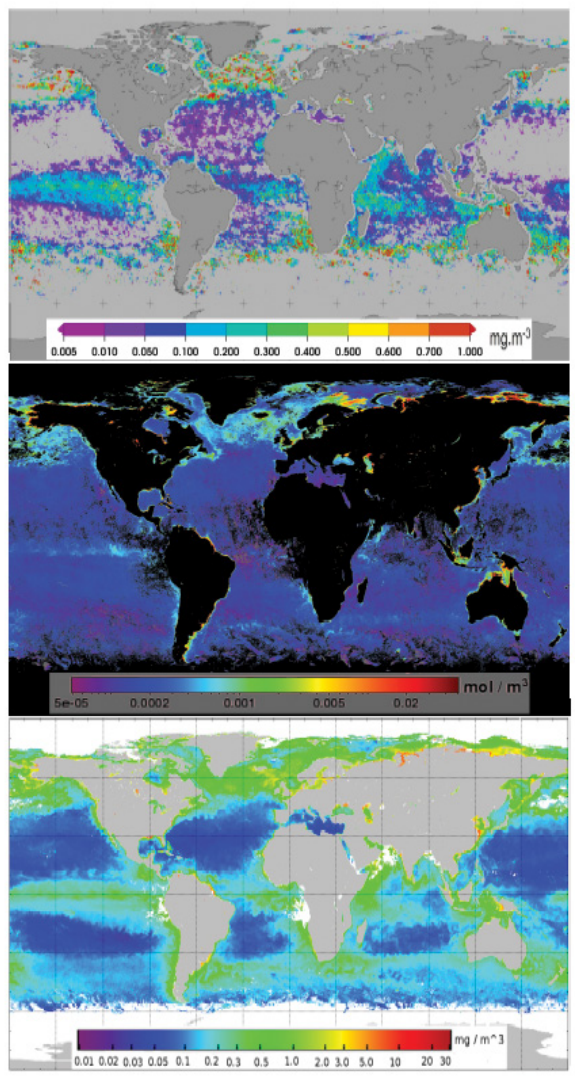
Fig. 1. A sample comparison of three monthly mean products, all obtained in August 2005: the PhytoDOAS coccolithophore chl a (upper panel) retrieved from SCIAMACHY data, the PIC concen- tration (middle panel) from the MODIS-Aqua level-3 products, and the total chl a (lower panel) from the GlobColour level-3 merged data.